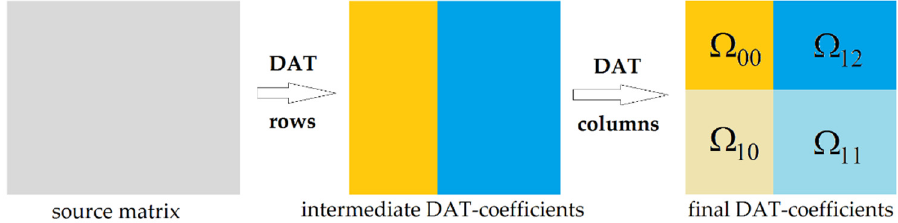
Figure 5. Discrete atomic transform of a matrix: the procedure DAT2 of depth n. It is clear that DAT1 and DAT2 are significantly different. The output matrices have different structures, and their elements have different meanings. For this reason, complete information about the matrix transform applied is required in order to reconstruct the original matrix D. Note that various mixtures of DAT1 and DAT2 can be applied. For example, first, DAT2 of the depth 1 can be applied, and then each block of the resulting matrix can be transformed by DAT1 (Figure 6). In addition, different combinations of DAT-procedure reuse can be applied to blocks of the matrix obtained at the previous step. Hence, there is a great variety of constructions of the two-dimensional DAT. We stress that any attempt to correctly reconstruct the source matrix D using the given matrix of DAT-coefficients Ω requires huge computational resources if comprehensive infor- mation about DAT-procedure applied is absent. Moreover, the source matrix can be di- vided into blocks, each of which can be then transformed by DAT. Notice that this ap- proach is used in such algorithms as JPEG [61] and WebP [62]. Figure 6. A mixture of DAT1 and DAT2. It is obvious that changes in the structure of DAT affect the DAC efficiency including complexity, memory savings, and metrics of quality loss. For this reason, the following question is of particular interest: what is the dependence of the DAC compression effi- ciency on the structure of DAT applied? An answer to this question makes it possible to